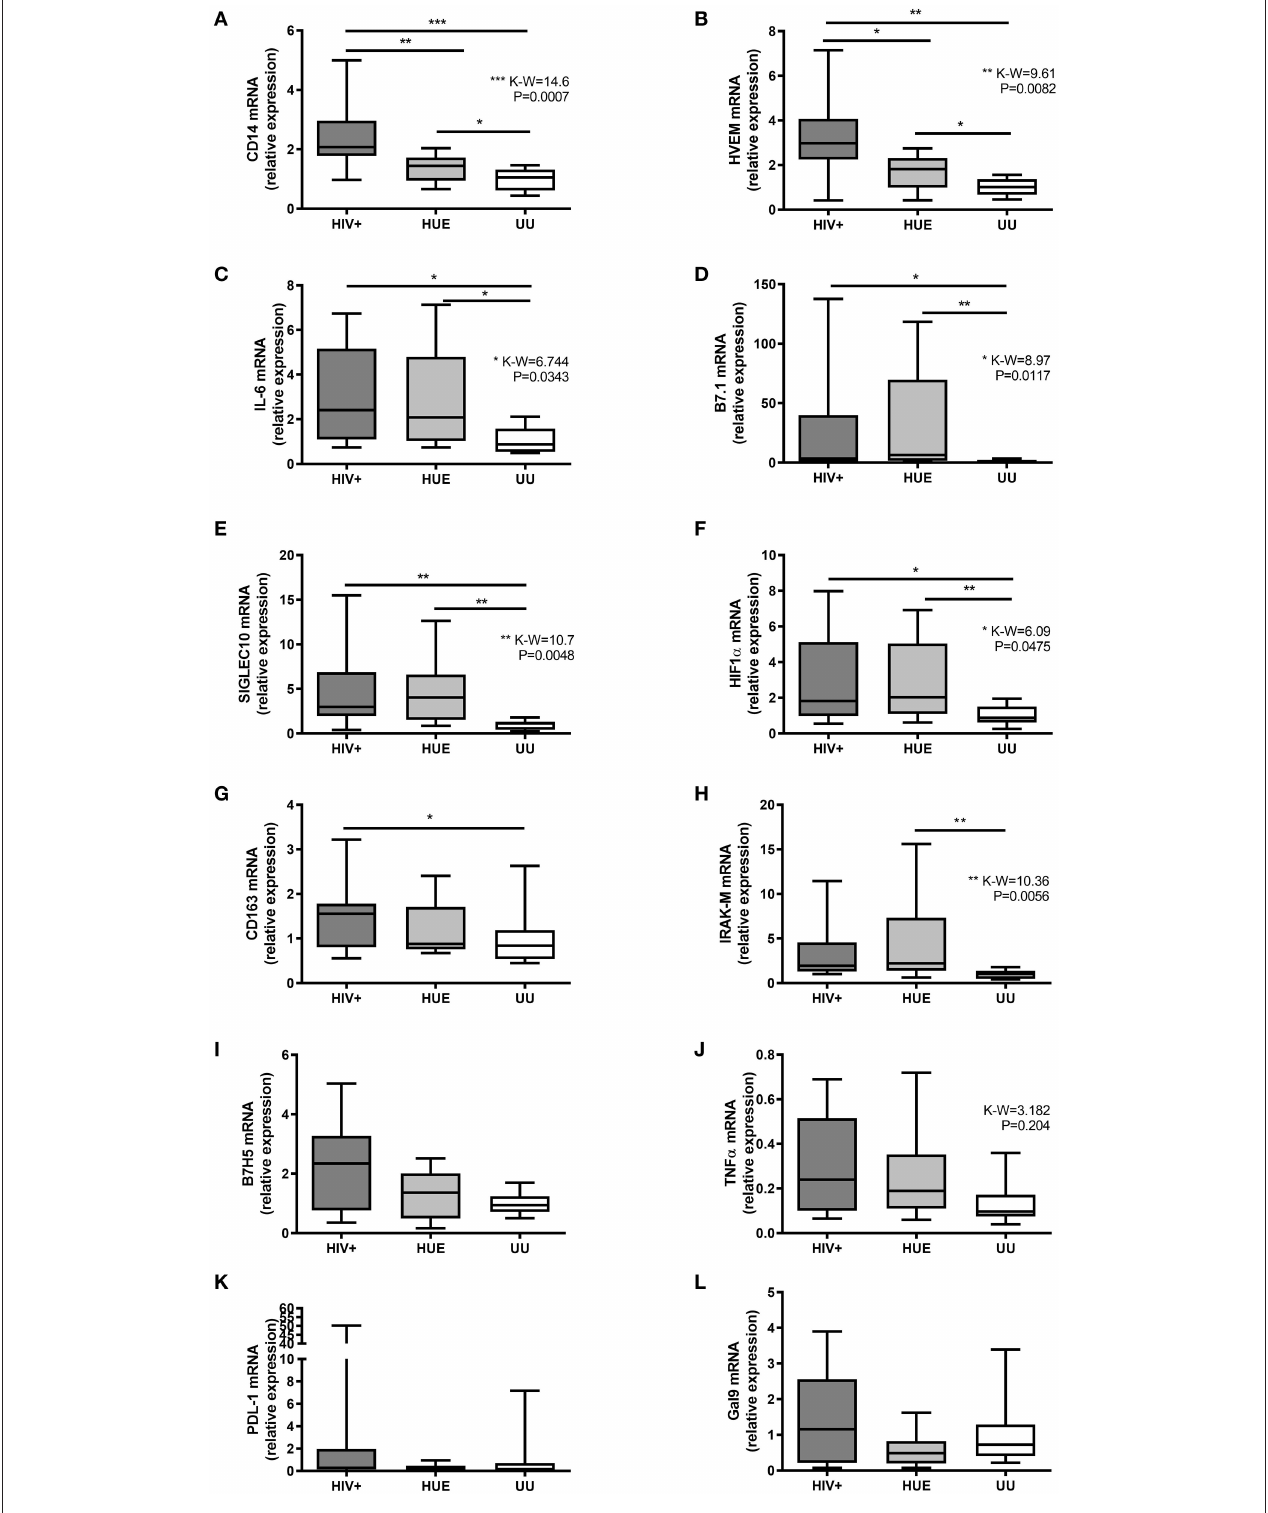
FIGURE 3 | Relative expression by RT-qPCR of CD14 (A) , HVEM (B) , IL-6 (C) , B7.1 (D) , Siglec-10 (E) , HIF-1 α (F) , CD163 (G) , IRAK-M (H) , B7H5 (I) , TNF α (J) , PD-L1 (K) , and Galectin-9 (L) genes on mRNA extracted from DBS from a pediatric cohort of DRC. HIV+, HIV-infected children; HEU, HIV-exposed but born uninfected children; UU, HIV-unexposed and uninfected children; P-values and Kruskal-Wallis statistics (K-W) for statistically significant biomarkers are shown. * P < 0.05; ** P < 0.01; *** P < 0.001 on Mann-Whitney U-test between groups. Figure presented in IAS Congress 2019, abstract TUPEC444.